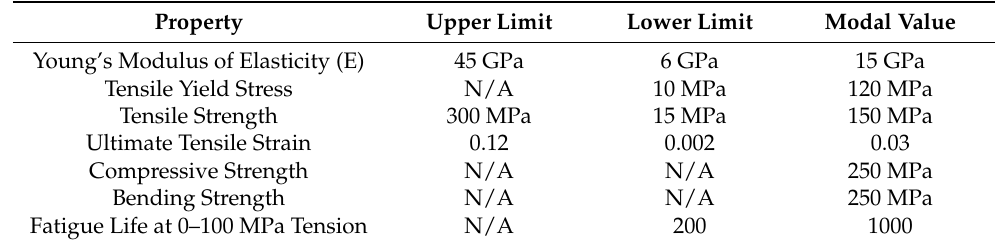
Table 1. Some values of mechanical properties of cortical bone. Reprinted with permission from ref. [58]. 2008, Woodhead Publishing